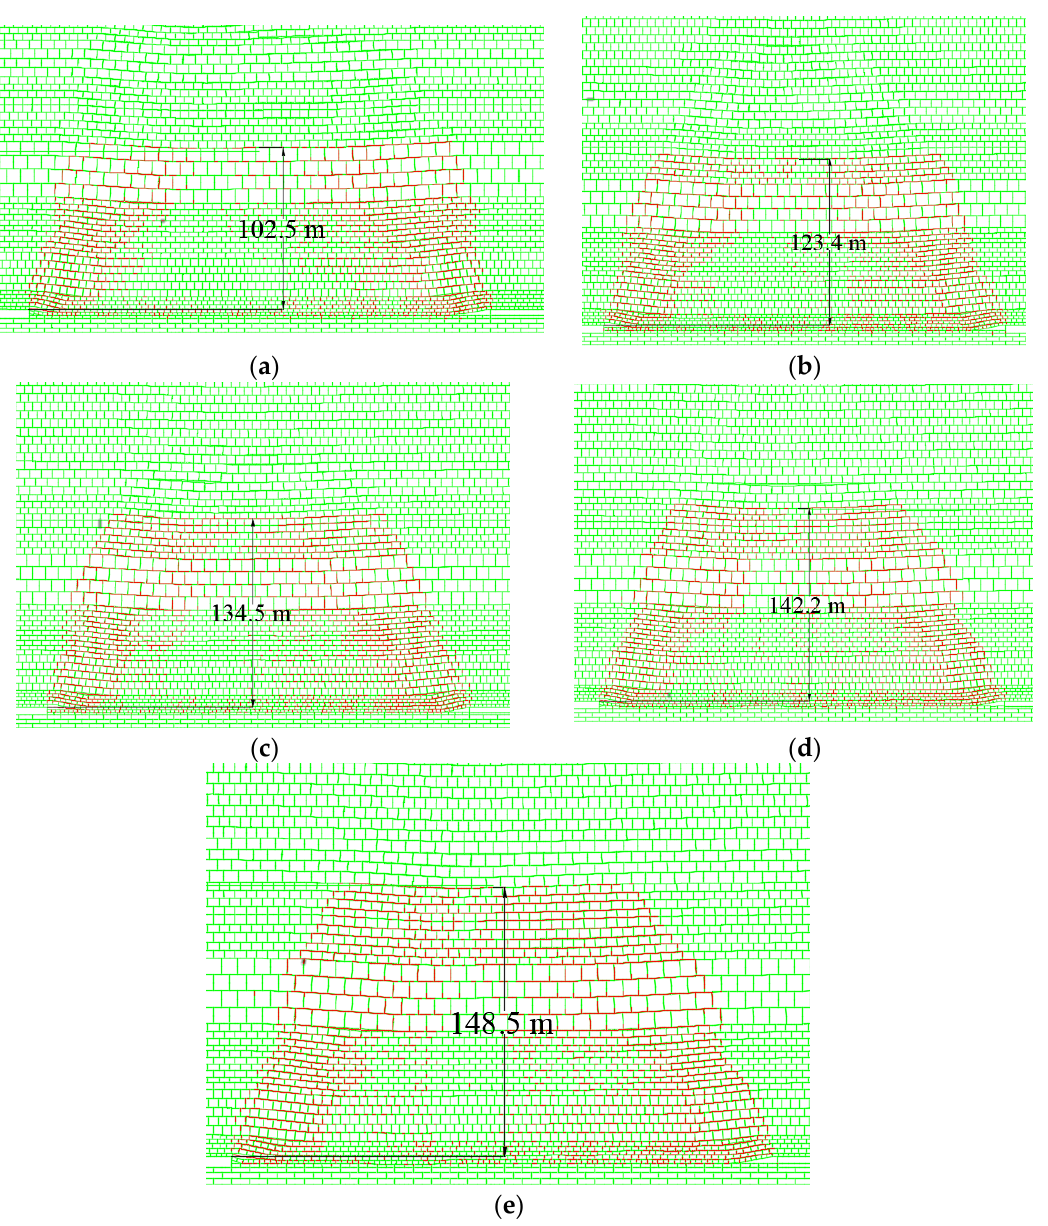
Figure 12. The development characteristics of overlying strata fractures under different buried depth conditions. ( a ) Buried depth 200 m; ( b ) Buried depth 250 m; ( c ) Buried depth 300 m; ( d ) Buried depth 350 m; ( e ) Buried depth 400 m.